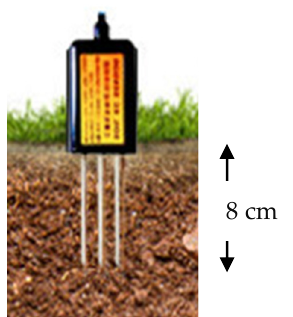
Figure 3. MEC10 probe sensors buried 8 cm deep in the soil.